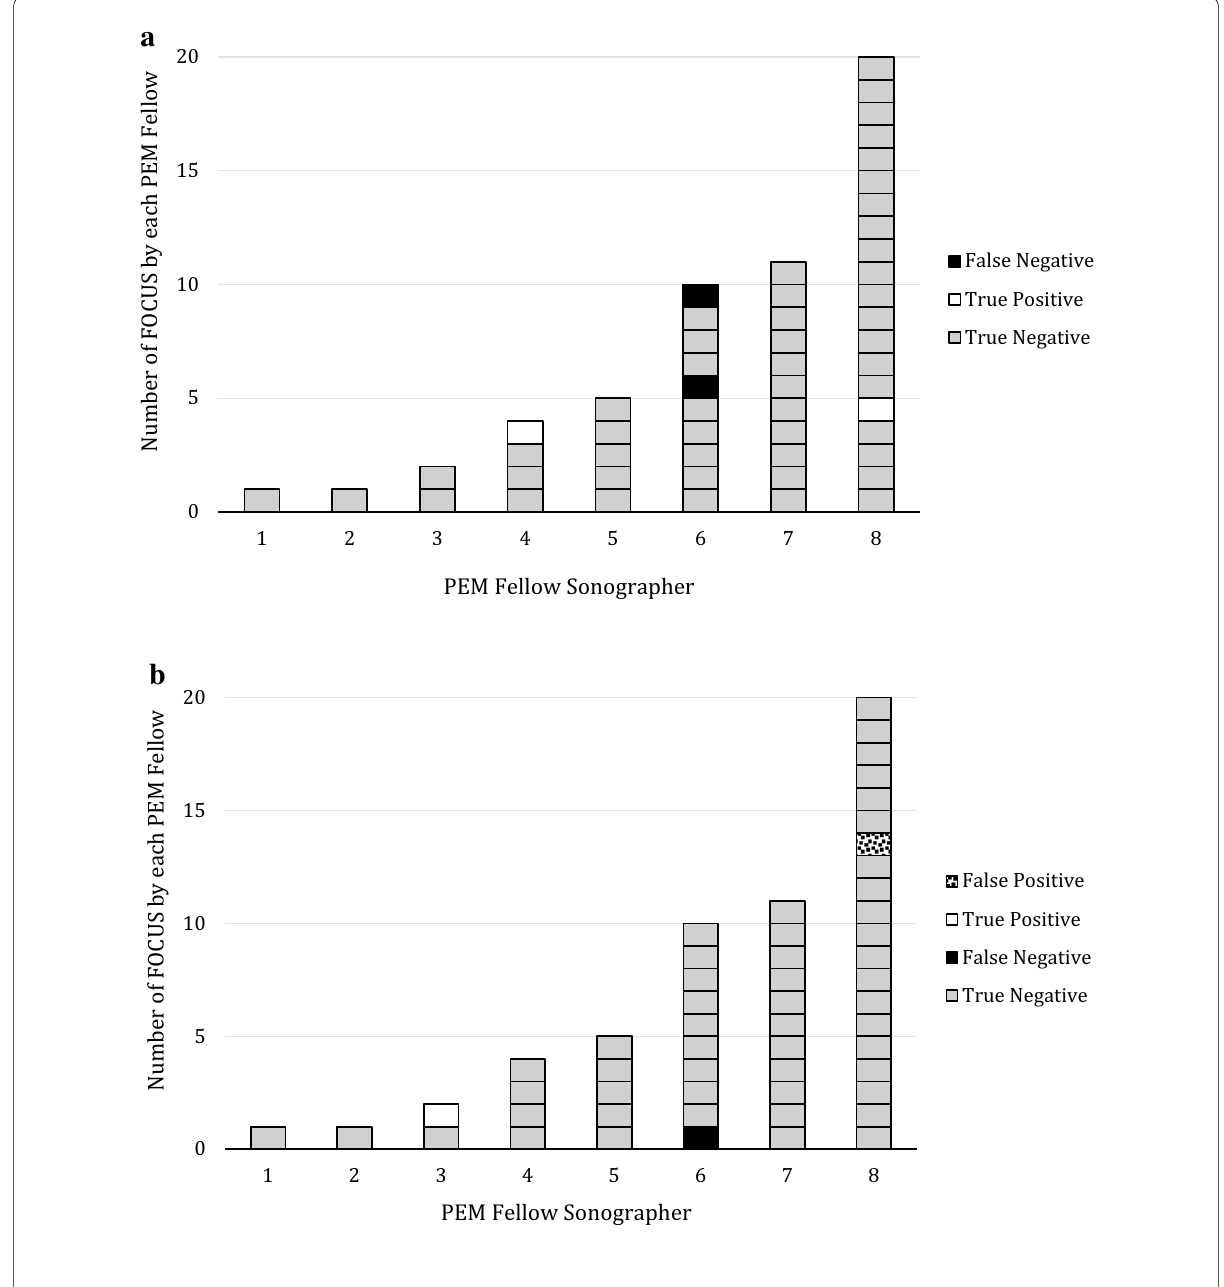
Fig. 1 Test characteristics of FOCUS performed by PEM